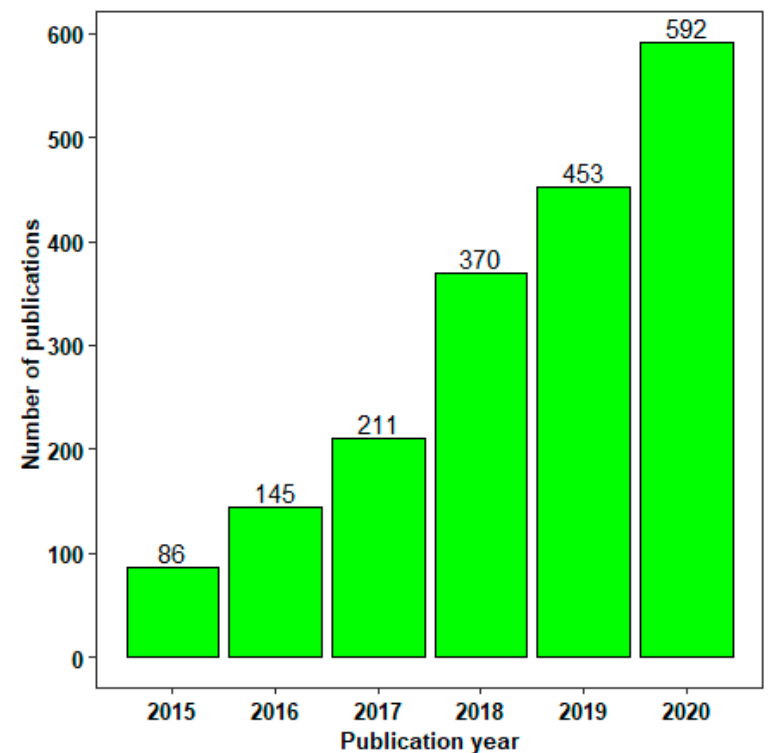
Figure 2. Number of publications involving 3DP techniques by year (2015–2020).